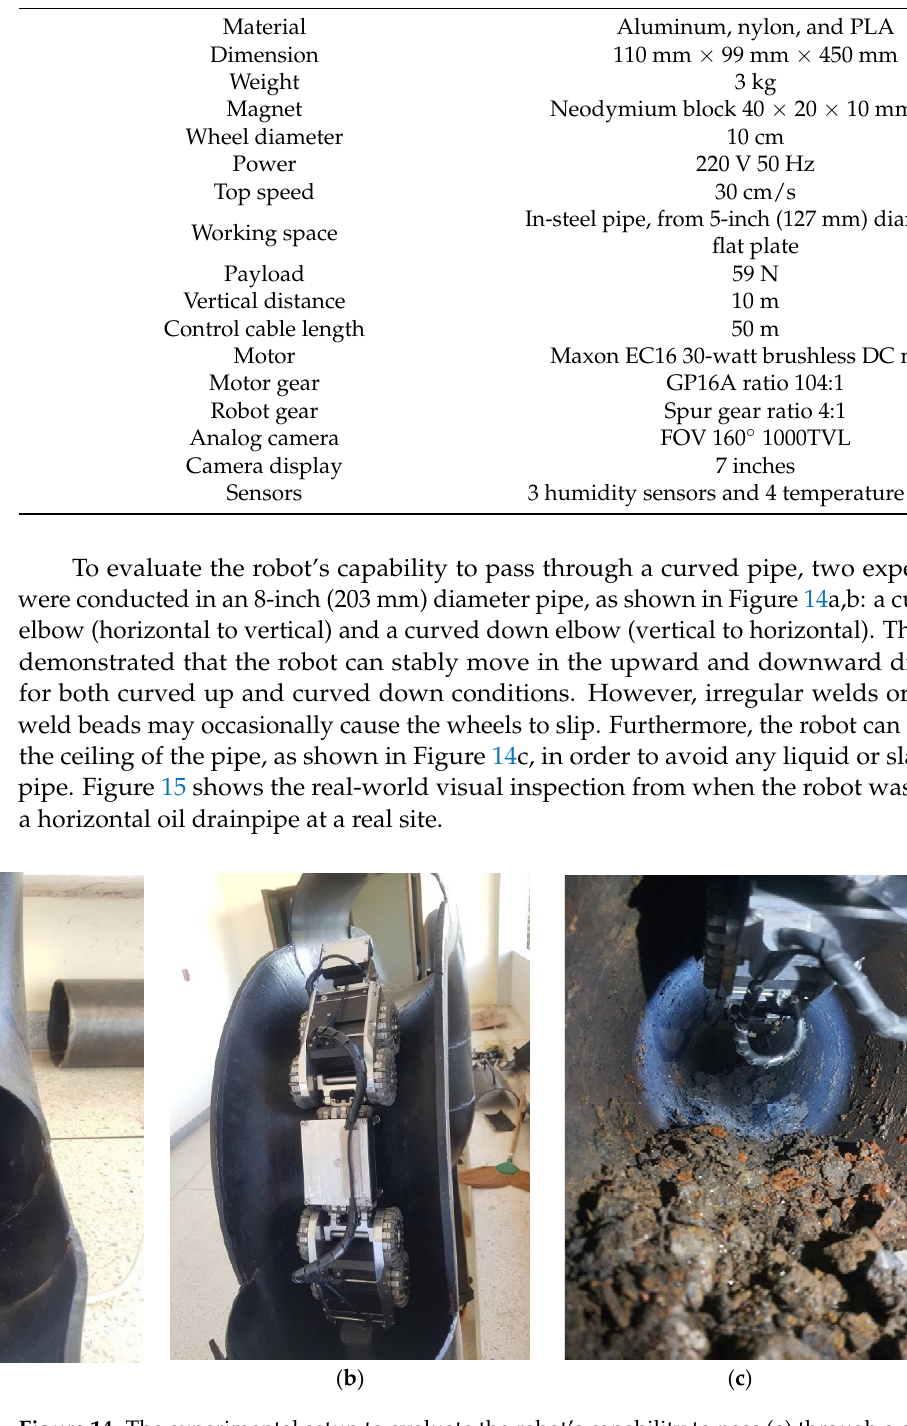
Figure 14. The experimental setup to evaluate the robot’s capability to pass ( a ) through a curved up elbow, ( b ) through a curved down elbow, and ( c ) by attaching to the ceiling.